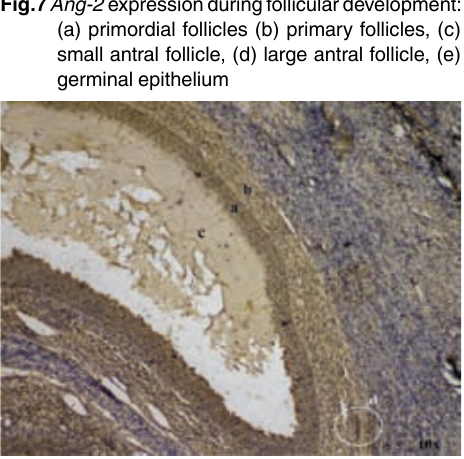
Fig.9 (a) mural granulosa cells, (b) theca interna cells, (c) follicular fluid (d) Capillary